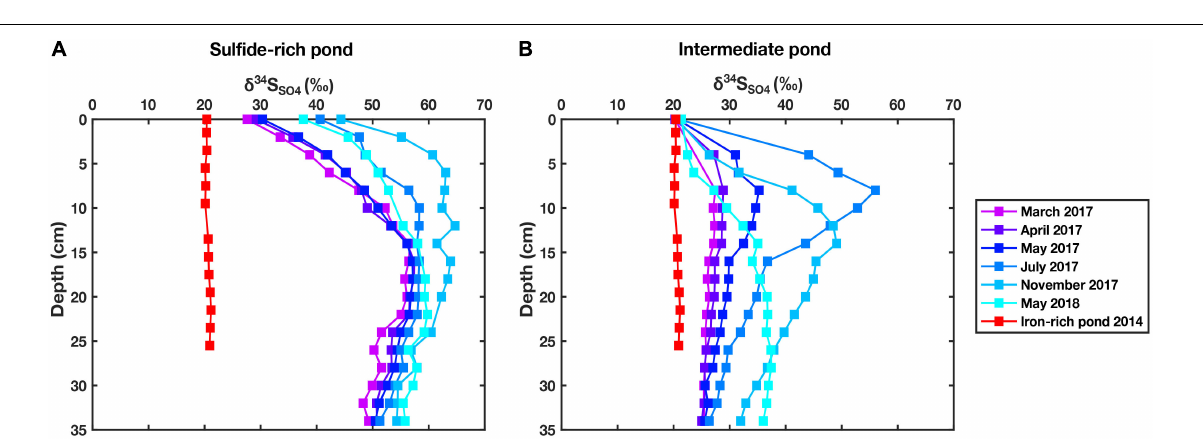
FIGURE 6 | (A) δ 34 S SO4 measured in porewater samples over a 14-month period for pond A (sulfide-rich pond). Data from an iron-rich pond sampled in 2014 is added for comparison. Analytical uncertainty is 0.2 . (B) δ 34 S SO4 measured in porewaters over a 14-month period for pond B (intermediate pond). Data from an iron-rich pond from 2014 is added for comparison. Analytical uncertainty is (cid:104)